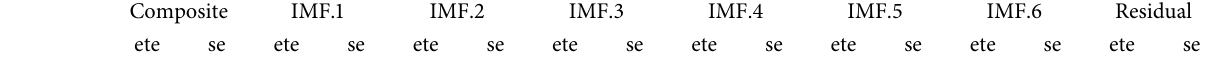
Table 2: R´enyian transfer entropies between bonds and global